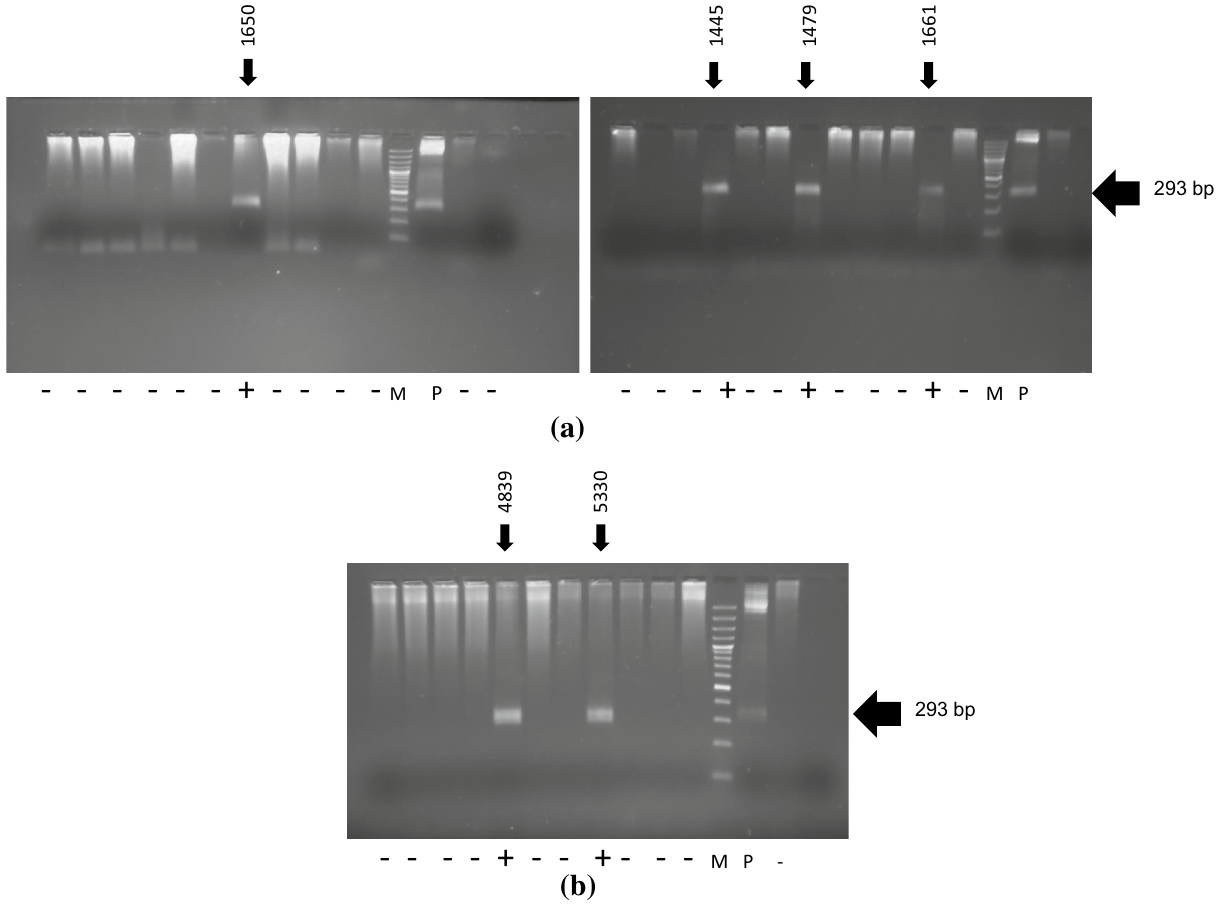
Figure 1. Screening of birds for identification of transgene integration during 1st and 2nd generation. ‘+’ indicates transgenic positive birds possessing 293 bp amplified product. The 293 bp fragment is located at the back bone of pENTR™/U6 vector. ‘−’ indicates transgenic negative birds. The numericals with arrow indicate the wing band No. of transgenic birds. M = 100 bp ladder DNA marker. P = Amplified fragment from shRNA recombinant plasmid as positive control. ( a ) = 1st generation birds. ( b ) = 2nd generation